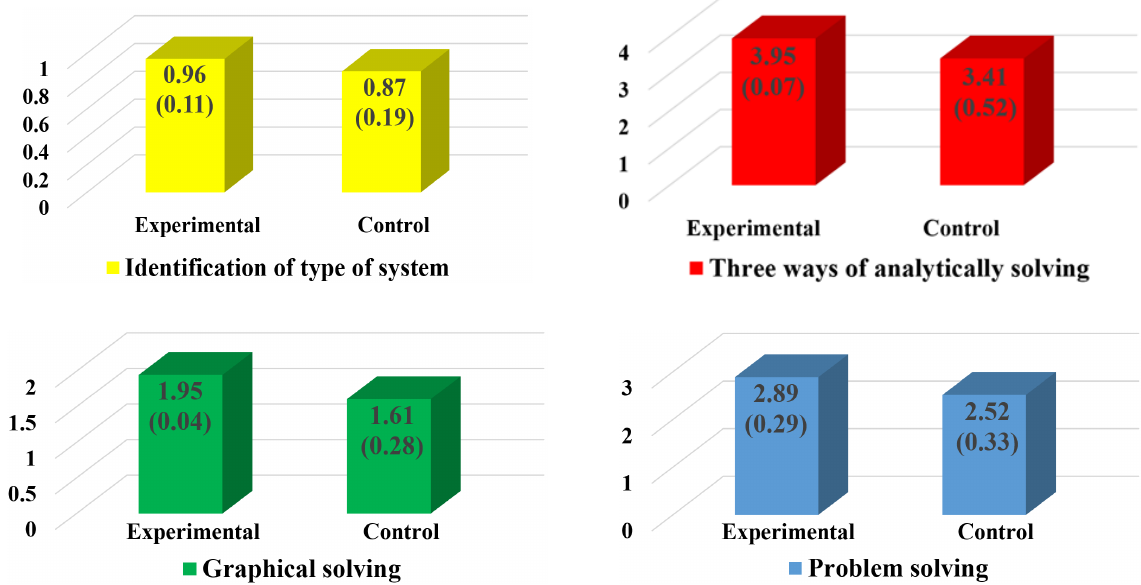
Figure 4. Experimental and control group scores and standard deviations by mathematics domain.